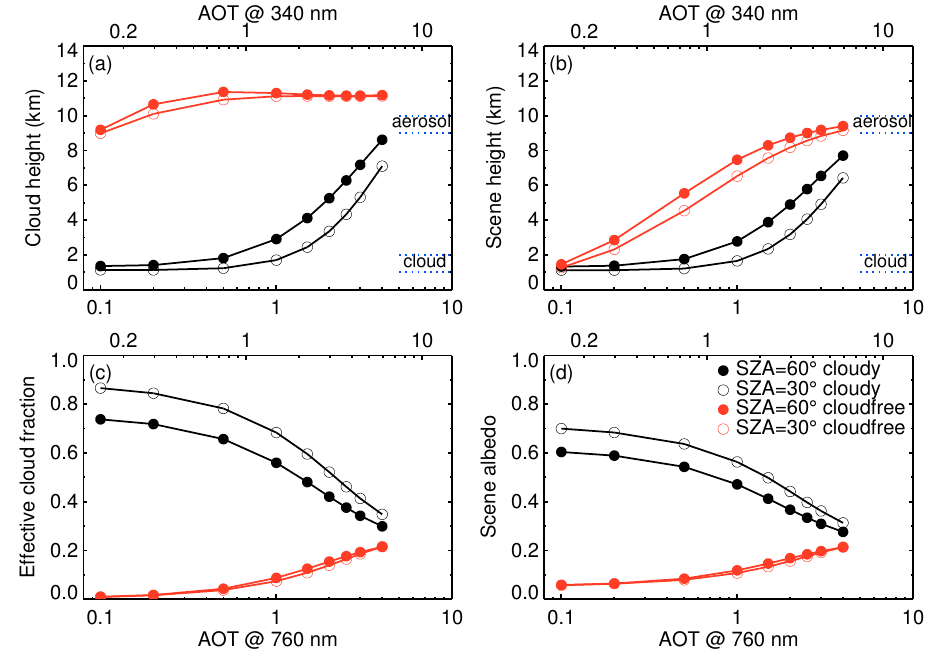
Fig. 5. FRESCO retrieval results of (a) cloud height, (b) scene height, (c) effective cloud fraction, and (d) scene albedo using simulated O 2 A band spectra for dust aerosols in a cloud free scene and in a cloudy scene (COT=20). The aerosol optical thickness (AOT) is 0–4. The cloud layer is located between 1 and 2km altitude, and the location of the aerosol layer is between 9 and 10km. The location of aerosol and cloud layers is indicated with dashed lines. Surface albedo is 0.05. Results for two solar zenith angles are plotted, 60 ◦ and 30 ◦ . Viewing direction is nadir. The y-axes, “cloud height” and “effective cloud fraction”, represent “aerosol height” and “effective aerosol fraction” for cloud free scenes.